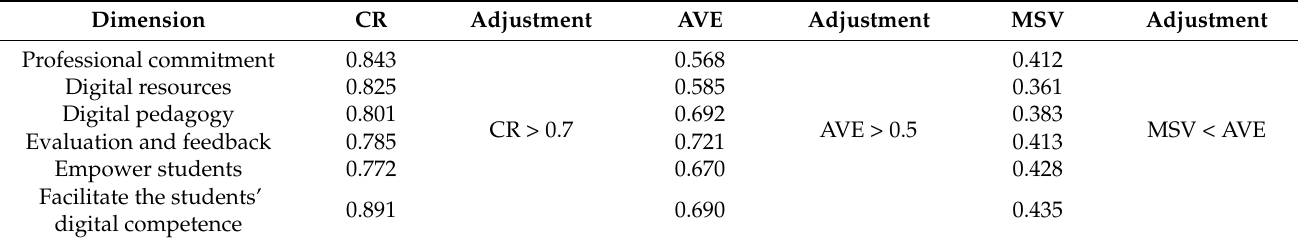
Table 2. Convergent and discriminant validity of the